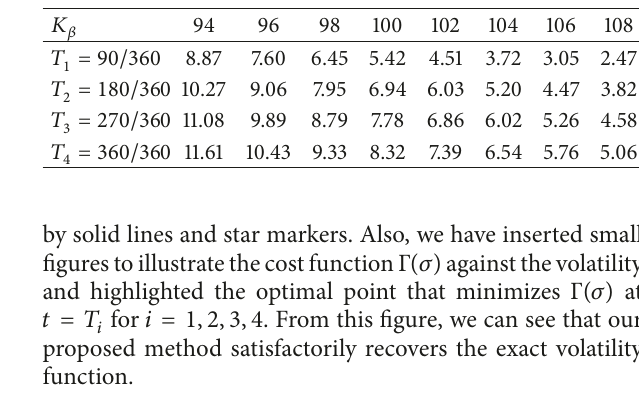
Table 3: European call option prices generated by the volatility function 𝜎(𝑡) = 0.3/3 𝑡